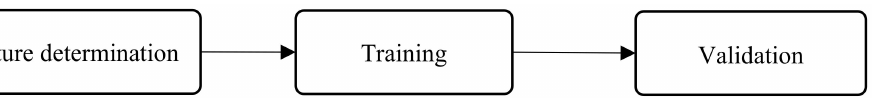
Figure 7. Flow of the development of the ANN.